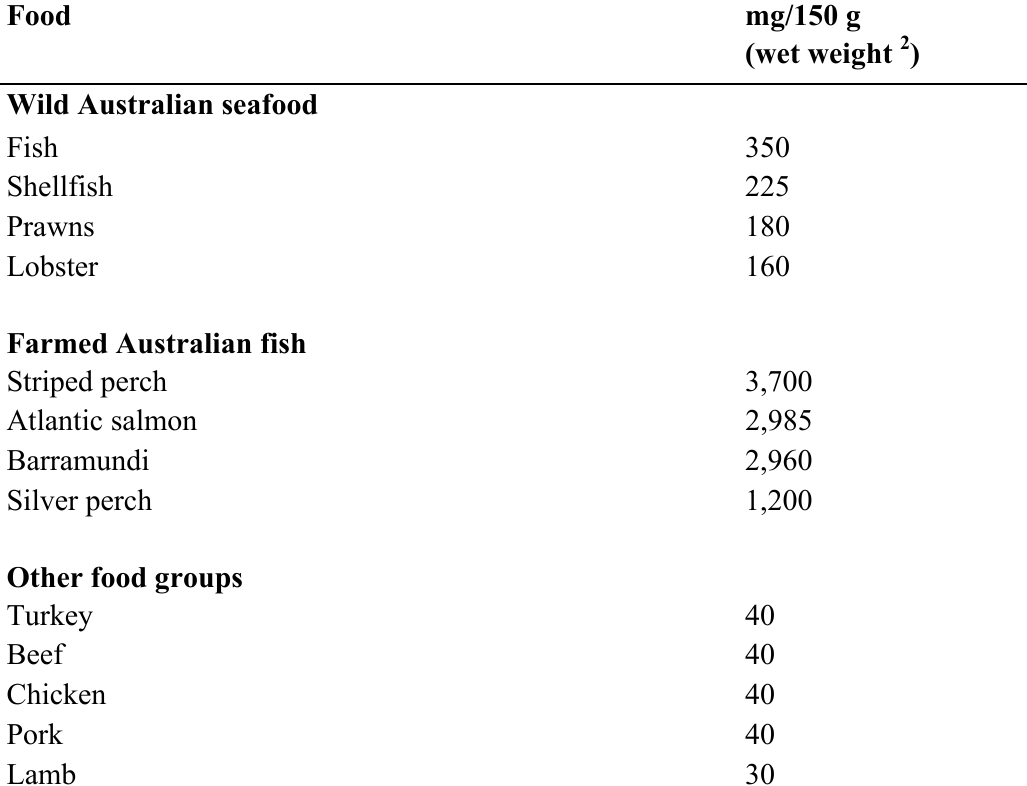
Table 1. Average LC omega-3 content of wild and farmed Australian seafood together with other food groups 1 .